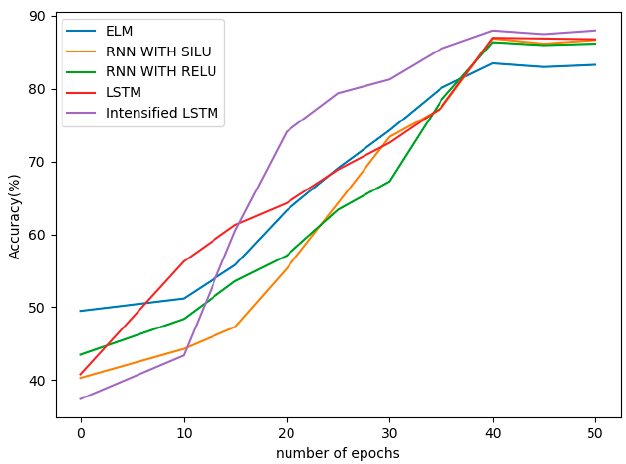
Figure 9. Comparison of accuracy for Neural Network based prediction models.